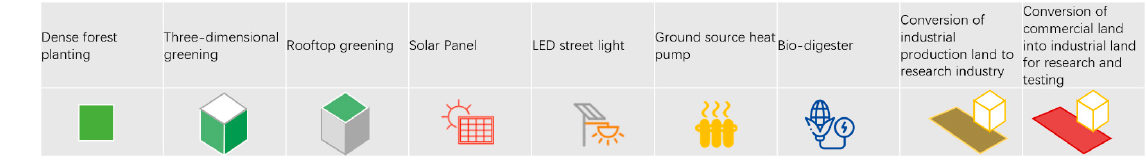
Figure 11. Diagram of different types of interventions.